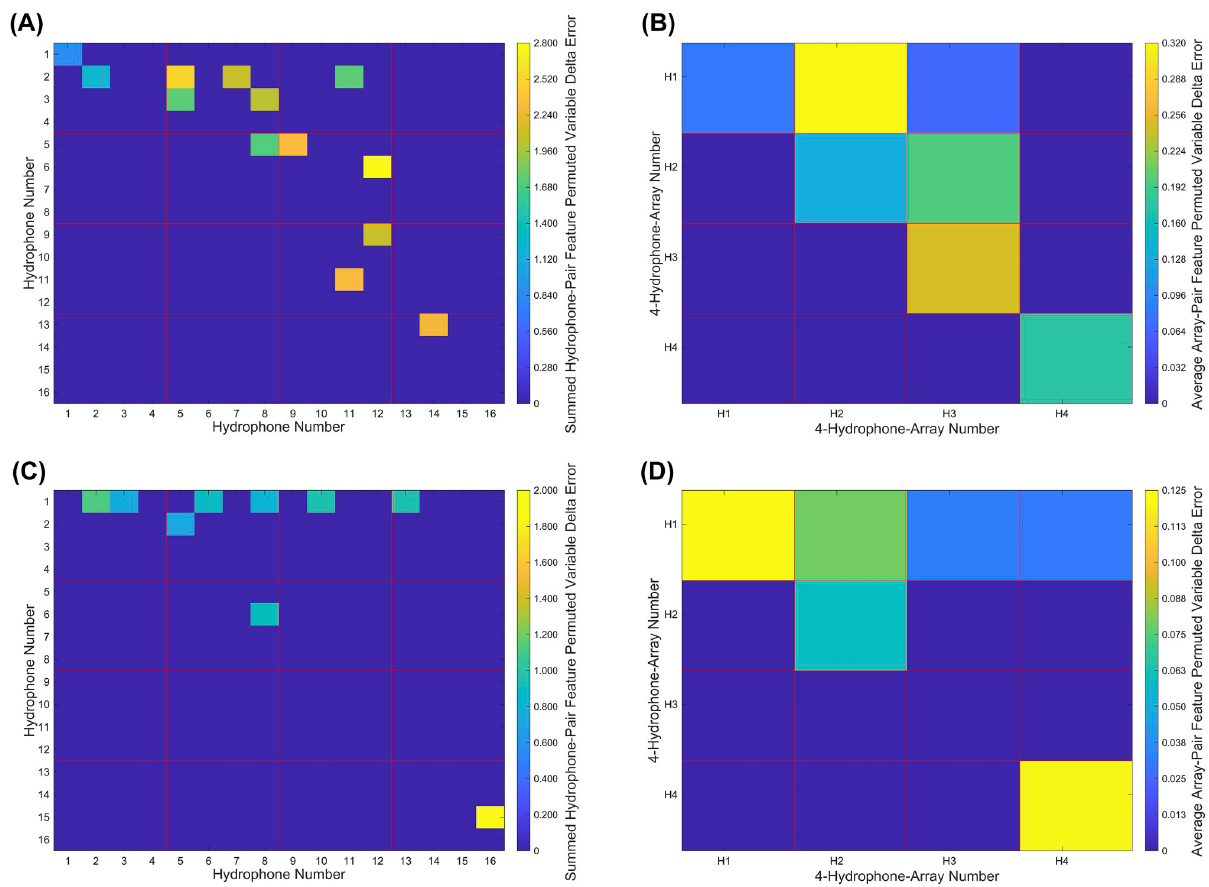
Fig 8. Cross-hydrophone and cross-4-hydrophone-array feature importances for the parsimonious random forest. Feature importance values for a parsimonious, 22-feature random forest model summed within corresponding hydrophone pairs to make (A) and (C), with those values subsequently averaged within 4-hydrophone-arrays to make (B) and (D). Note that values are equal between reversed hydrophone/4-hydrophone-array pairs (e.g., values are equal for hydrophone pairs 1-2 and 2-1) but plotted only once. (A) Cross-hydrophone importances for cross-correlation features. (B) Cross- 4-hydrophone-array importances for cross-correlation features. (C) Cross-hydrophone importances for TDOA features. (D) Cross-4-hydrophone- array importances for TDOA features.